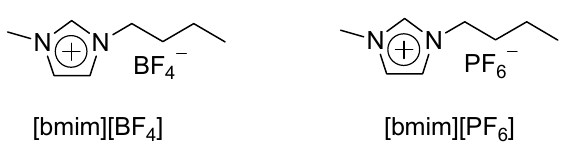
Scheme 2 . Structures of ionic